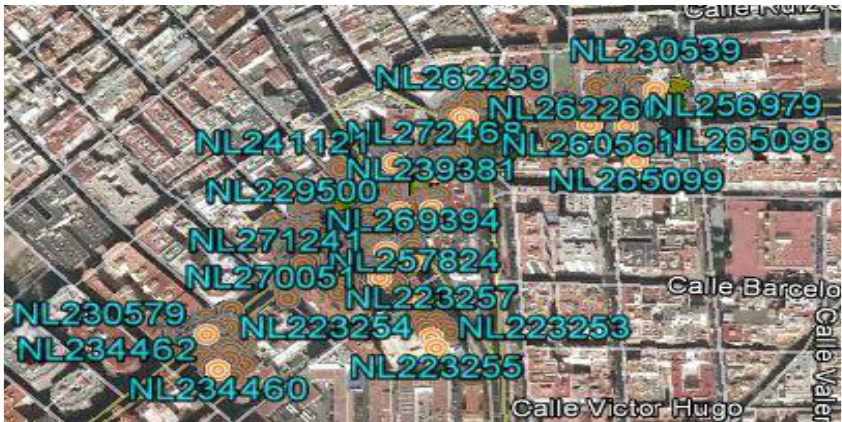
Figure 5. Cluster of type G3. The orange markings are position readings of the vehicle with a velocity of zero. There are two scheduled stop points in the area shown; however, all the readings have been grouped into one cluster, with a centroid at a distance of more than 15 m from the two scheduled